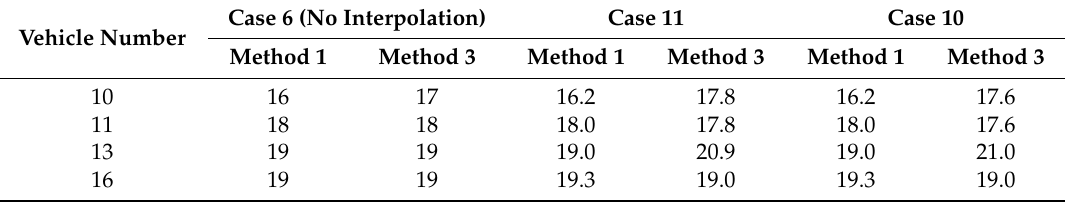
Table 6. Estimated sample delay for vehicles that traveled at speeds from 90 km/h to 112.5 km/h.